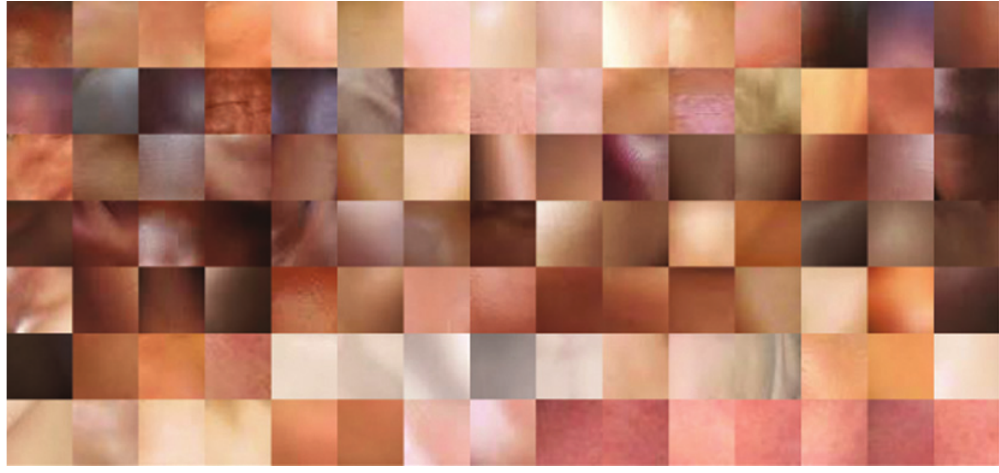
Figure 1. Samples of Human